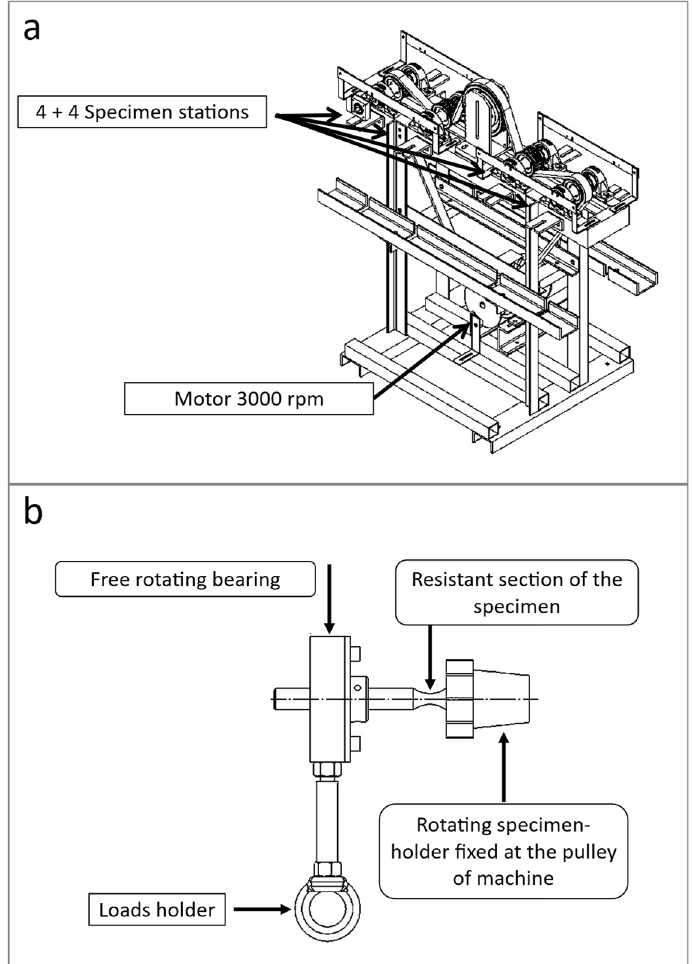
Figure 3. ( a ) Scheme of the eight stations rotating fatigue machine; ( b ) clamping system for the spec- imen.